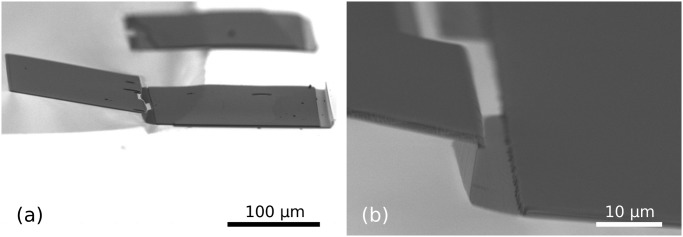
Final structure before folding.(a): Residual stress in the thin SiRN layers provoked a slight bending upward of the flap. (b): Zoom in at a stop-programmable hinge.